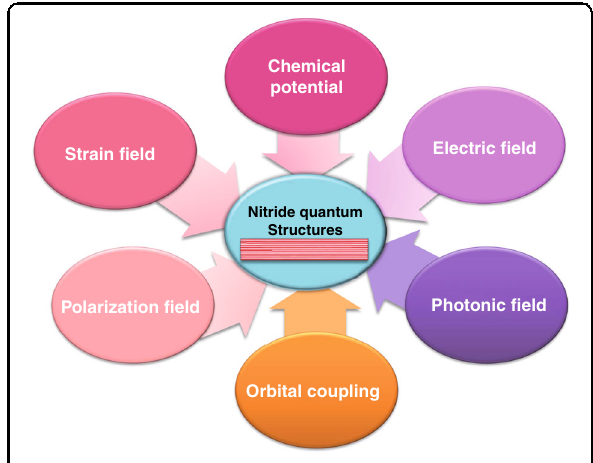
Fig. 2 Schematic of the impact of multiple physical fi elds on nitride quantum structures. These tunable multiple fi elds include strain fi eld, electric fi eld, optical fi eld, electromagnetic fi eld, the fi eld of chemical potential, orbital coupling, etc.